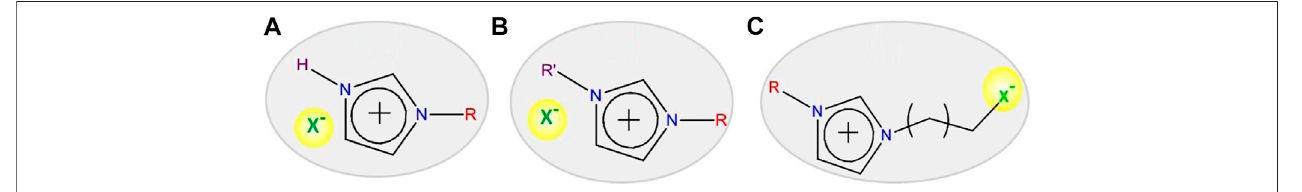
FIGURE 4 | Task-speci fi c ionic liquids for particular applications: (A) protic, (B) aprotic, and (C) zwitterionic.